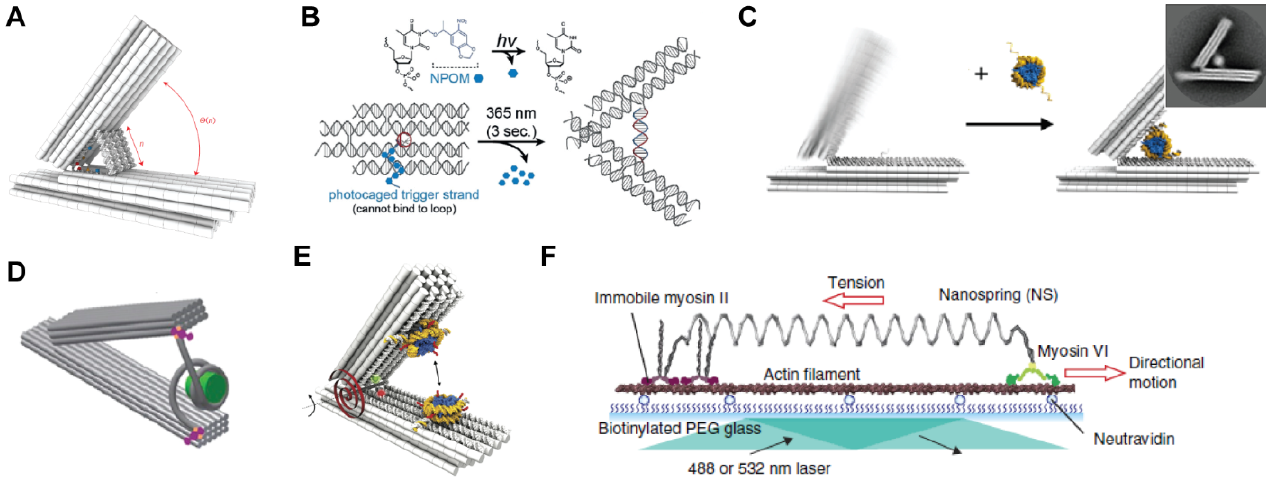
Figure 5. Applying forces using DNA nanodevices. ( A ) DNA nanocaliper with “adjuster” helices for Bohr radius resolution. Reprinted with permission from ref. [42], Copyright 2015 Springer Nature. ( B ) DNA nanotweezer with a photocaged trigger strand, allowing for rapid opening with a short pulse of UV light. Reprinted with permission from ref. [44], Copyright 2018 John Wiley and Sons. ( C , D ) Application of hinged DNA nanostructures to measure the biophysical properties of nucleosomes binding to DNA. Reprinted with permission from ref. [49,50], Copyright 2016 American Chemical Society. ( E ) DNA nanostructure for measuring the forces between two nucleosomes. Reprinted with permission from ref. [51], Copyright 2016 American Association for the Advancement of Science. ( F ) DNA origami nanospring for measuring the stall force of myosin motors. Reprinted with permission from ref. [52], Copyright 2016 Springer Nature.